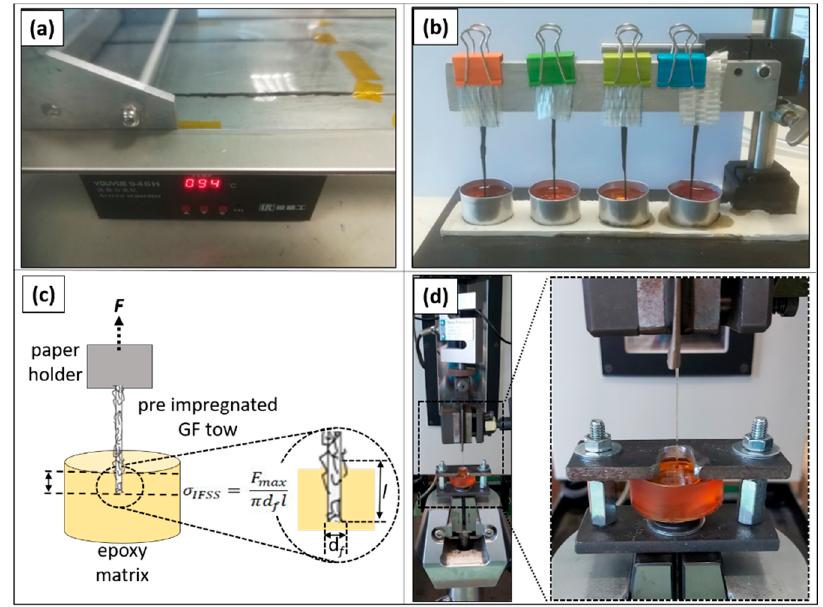
Figure 2. ( a ) A custom-made blade coating unit for the tows modifications, ( b ) impregnation of the tows within the epoxy resin mould utilizing the in-house built apparatus for the preparation of the pull-out test specimens, ( c ) schematic of a pull-out test specimen and ( d ) photo during the pull-out